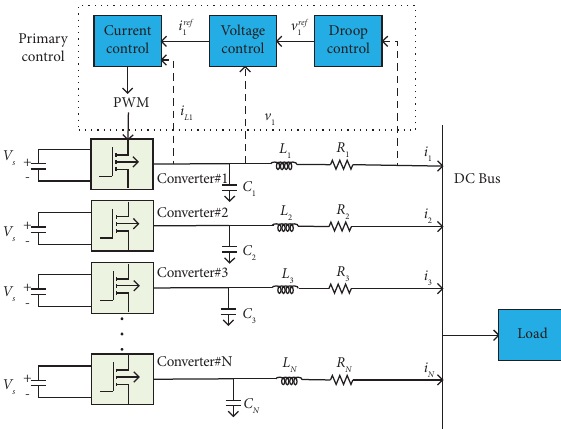
Figure 1: DC microgrid and primary control